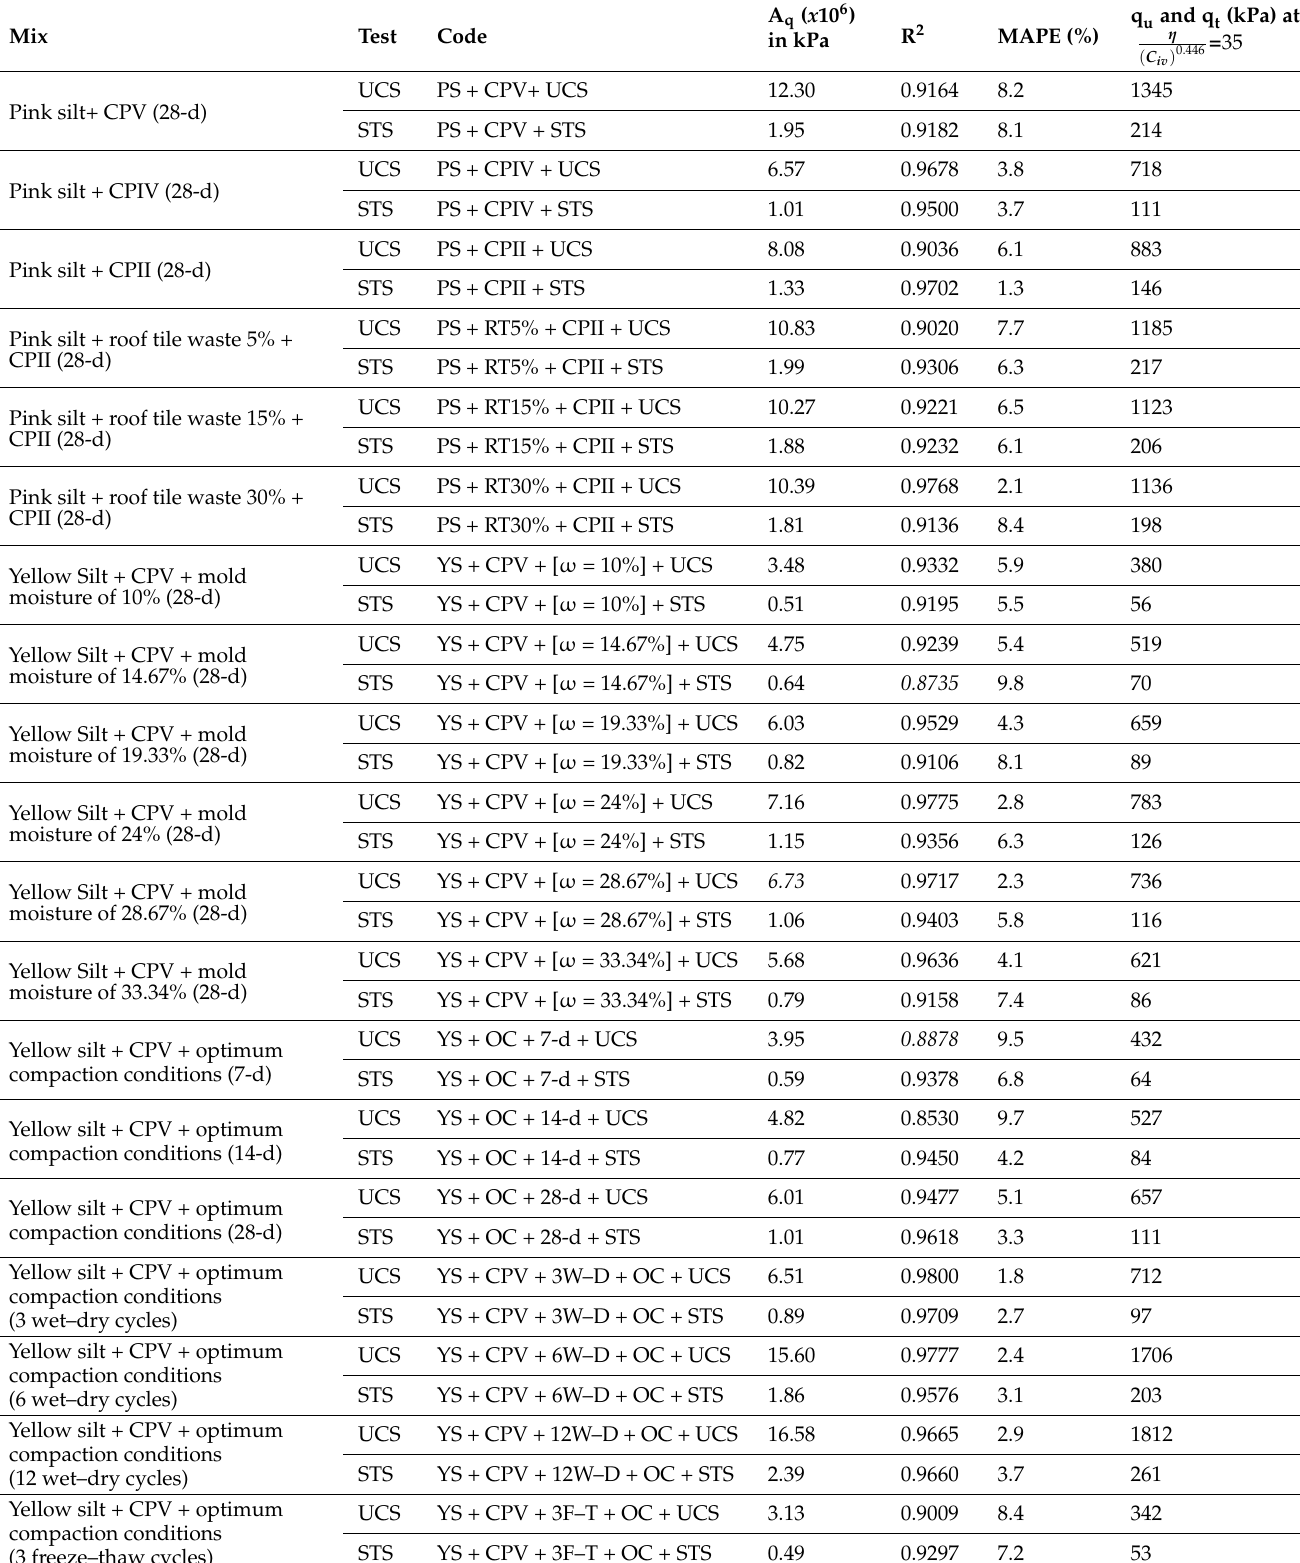
Table 7. Optimization for A q parameter for each mix using the coefficient of determination/MAPE and its corresponding normalization values with the